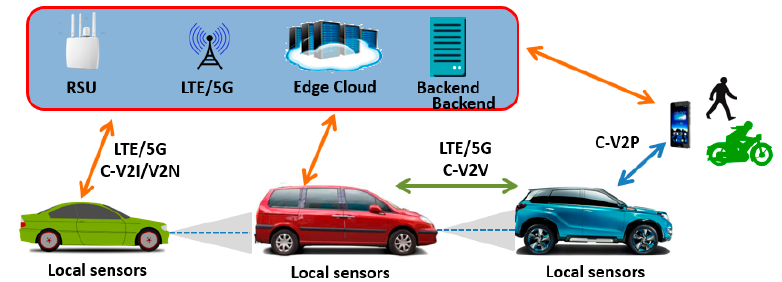
Figure 1. Envisioned cellular-based vehicle-to-everything (C-V2X) communication system.